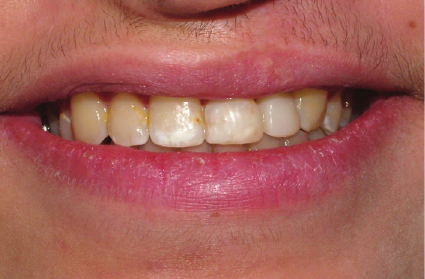
Figure 5: Case2 with cleft lip and palate.